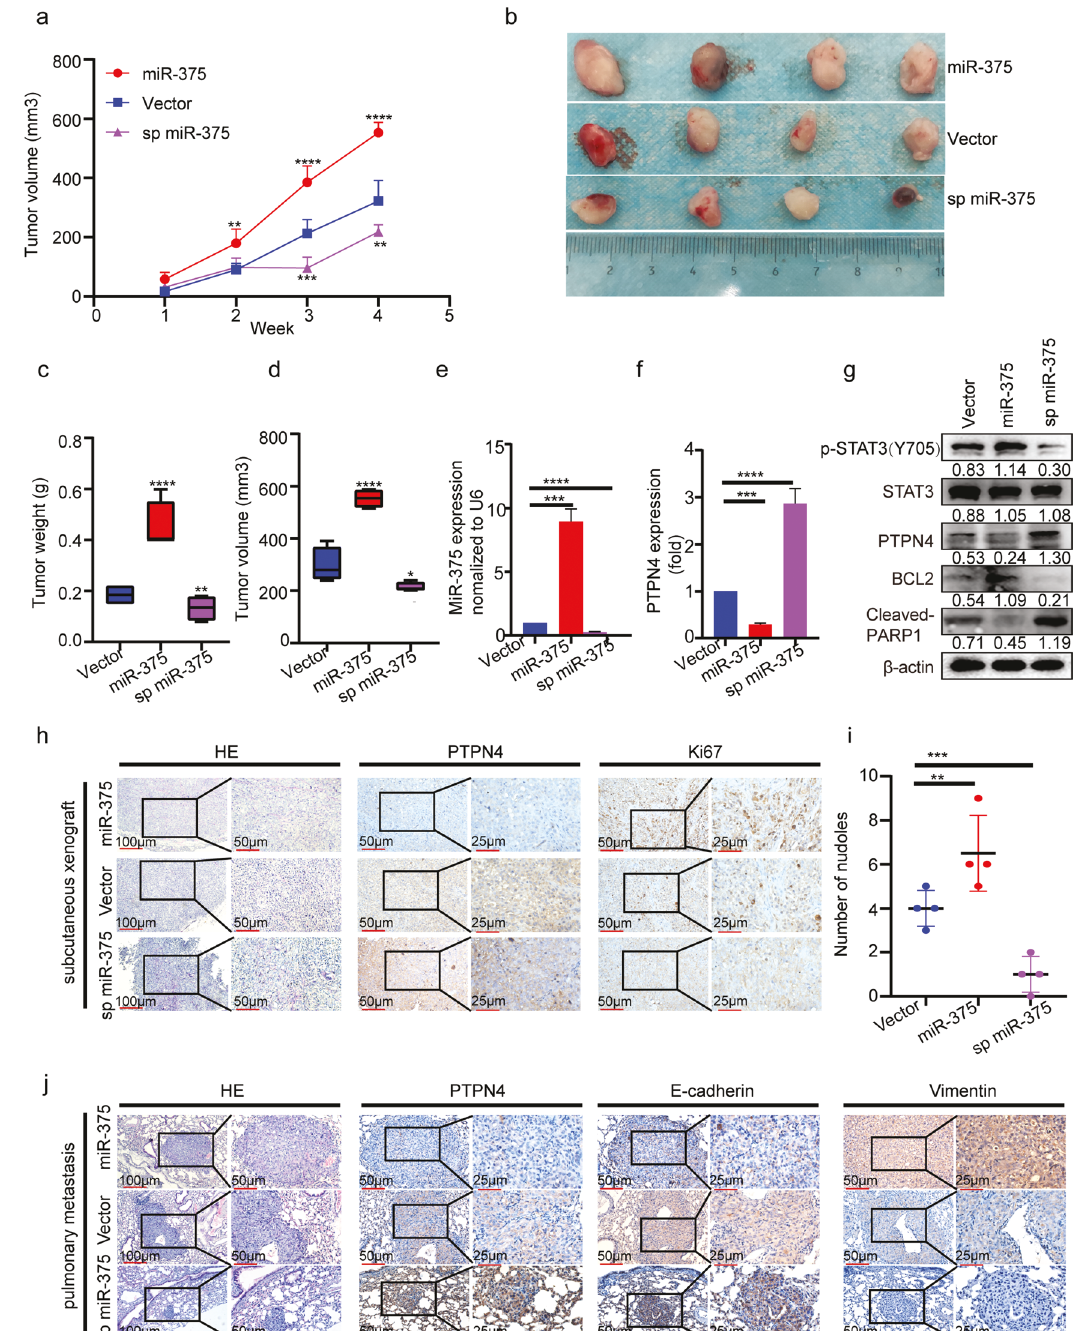
Fig. 5 MiR-375 overexpression promoted tumor growth and metastasis in vivo. a Tumor volume during follow-up for 4 weeks. ** p < 0.01, *** p < 0.001, **** p < 0.0001 vs. vector group. b Representative images of tumors in nude mice at the end timepoint. c Final tumor weight, d fi nal tumor volume, e the expression of miR-375, and f mRNA level of PTPN4 were determined by qRT-PCR in tumor tissues at the endpoint of follow-up. g Western blotting was performed to determine the expression of p-STAT3, PTPN4, BCL2 and cleaved-PARP, and h IHC analysis of the expression of PTPN4 and Ki67 in DU145 tumor tissues as the expression of miR-375 was manipulated. i Quanti fi cation of the metastatic nodules calculated from the discontinuous lung sections. j HE staining and IHC analysis of the expression of PTPN4, E-cadherin and Vimentin using metastatic lung tissue. Vector: DU145 cells stably transfected with pSUPER-RETRO-Puro-empty vector and pHB-U6-MCS-PGK-PURO- empty vector. MiR-375: DU145 cells stably transfected with pSUPER-RETRO-Puro-miR-375 vector and pHB-U6-MCS-PGK-PURO-empty vector. Sp miR-375: DU145 cells stably transfected with pHB-U6-MCS-PGK-PURO-miR-375 sponge vector and pSUPER-RETRO-Puro-empty isolated from the supernatant of the cell culture (Supplementary hucMSCs were grown in serum-free medium and characterized by Fig. 7c). After their size distribution and concentration were tri-lineage differentiation assays and the signature of surface determined by NanoFlow (Supplementary Fig. 7d), exosome- markers at the 4th passage (Supplementary Fig. 7a, b). Exosomes speci fi c markers were further veri fi ed with western blotting with diameters of 30 – 150 nm, as determined by TEM, were